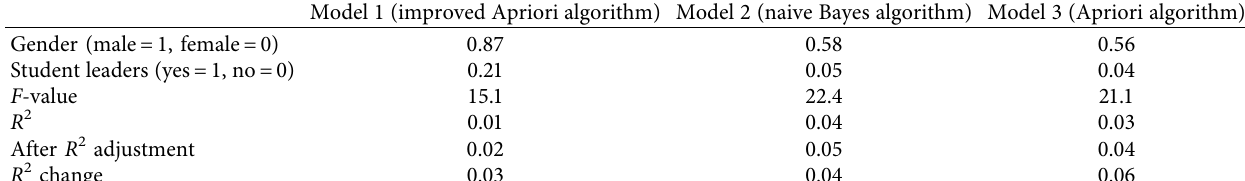
Table 2: Regression analysis of self-management and interpersonal relationship adjustment.